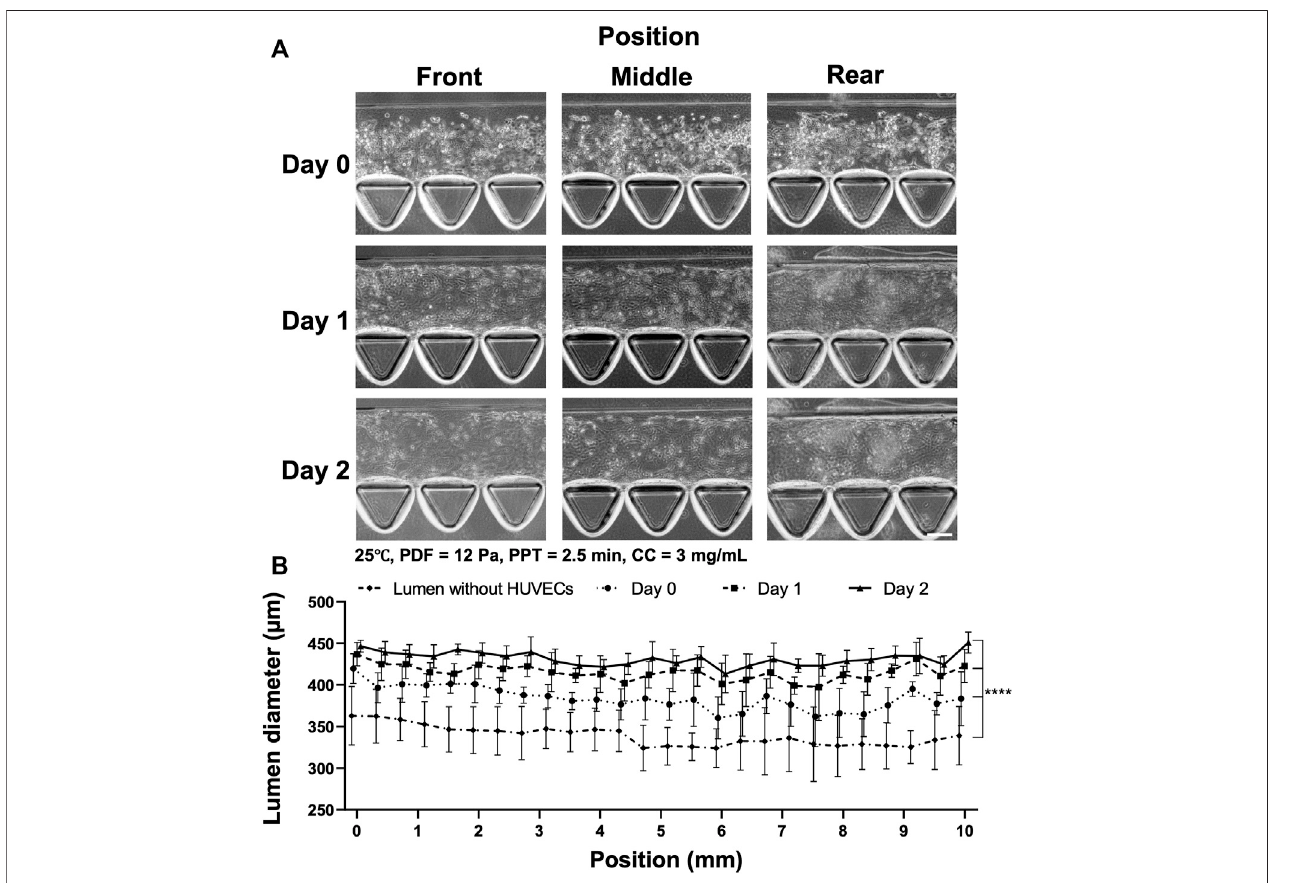
FIGURE 6 | Process of HUVEC seeding and vessel formation in two days in the collagen lumen formed at 25 ° C, PDF at 12 Pa, PPT at 2.5 min, and CC at 3 mg ml − 1 . (A) Images of HUVEC seeding and vessel formation in 2 days at different locations of the device. Front (1.2 – 2 mm), middle (4.8 – 5.6 mm) and rear positions (8.4 – 9.2 mm) in the media channel. (B) Quanti fi cation of the average lumen diameter over time at different locations in the media channel. Scale bar: 100